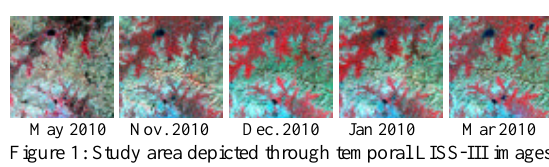
Figure 1: Study area depicted through temporal LISS-III